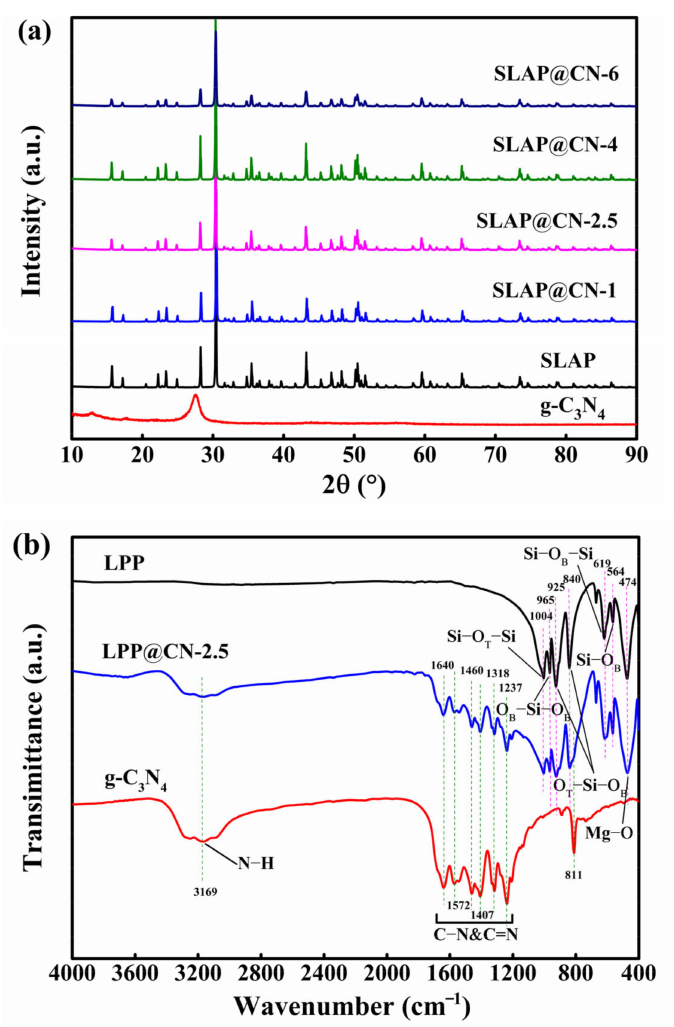
Figure 2. ( a ) XRD patterns of g-C 3 N 4 , SLAP, and SLAP@CN composite powders; ( b ) FTIR spectra of g-C 3 N 4 , SLAP, and